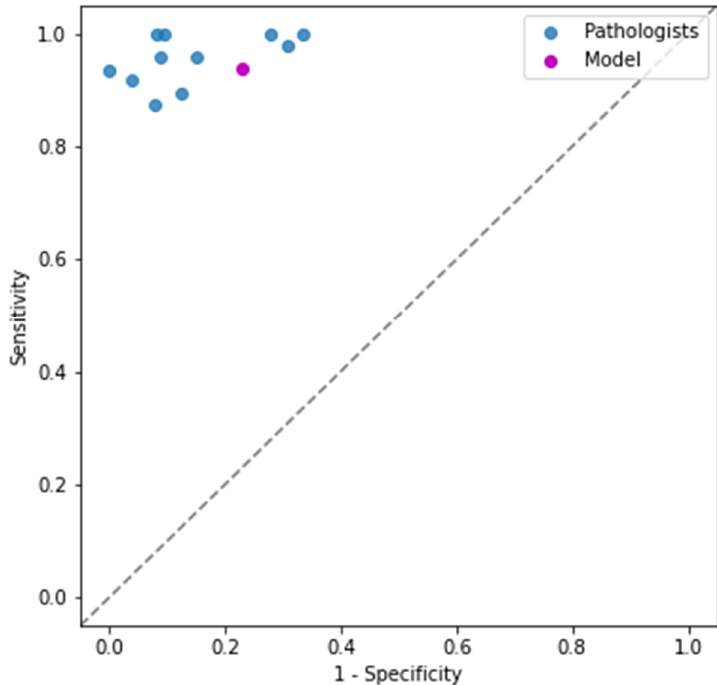
Figure 5. ROC curve comparing 11 dermatopathologists with U-NET algorithm. Demonstrated are individual dermatopathologists as well as U-NET algorithm in terms of sensitivity (true positive rate, recall) and 1-specificity (false positive rate). In the presented plot, cases where pathologists made a "maybe" call were not considered for their performance.